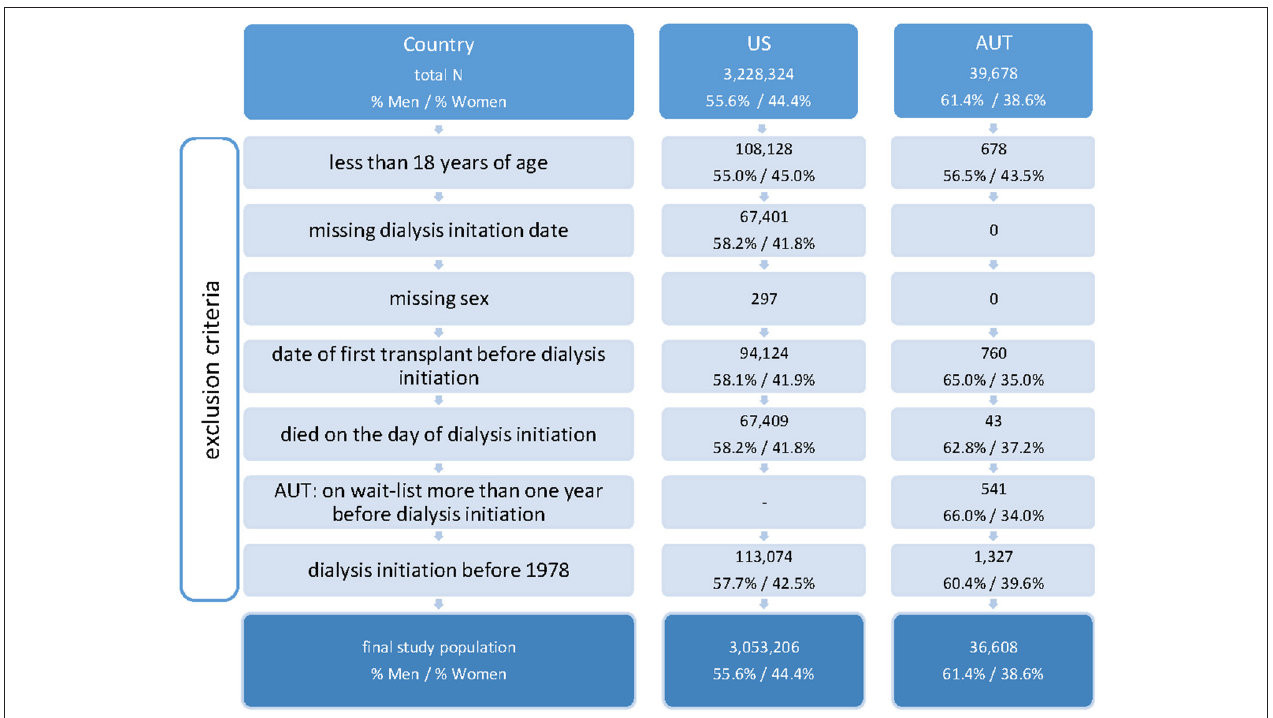
FIGURE 1 | Flowchart of study population. Total number of records, number or records meeting exclusion criteria (non-exclusive), and final study population, per